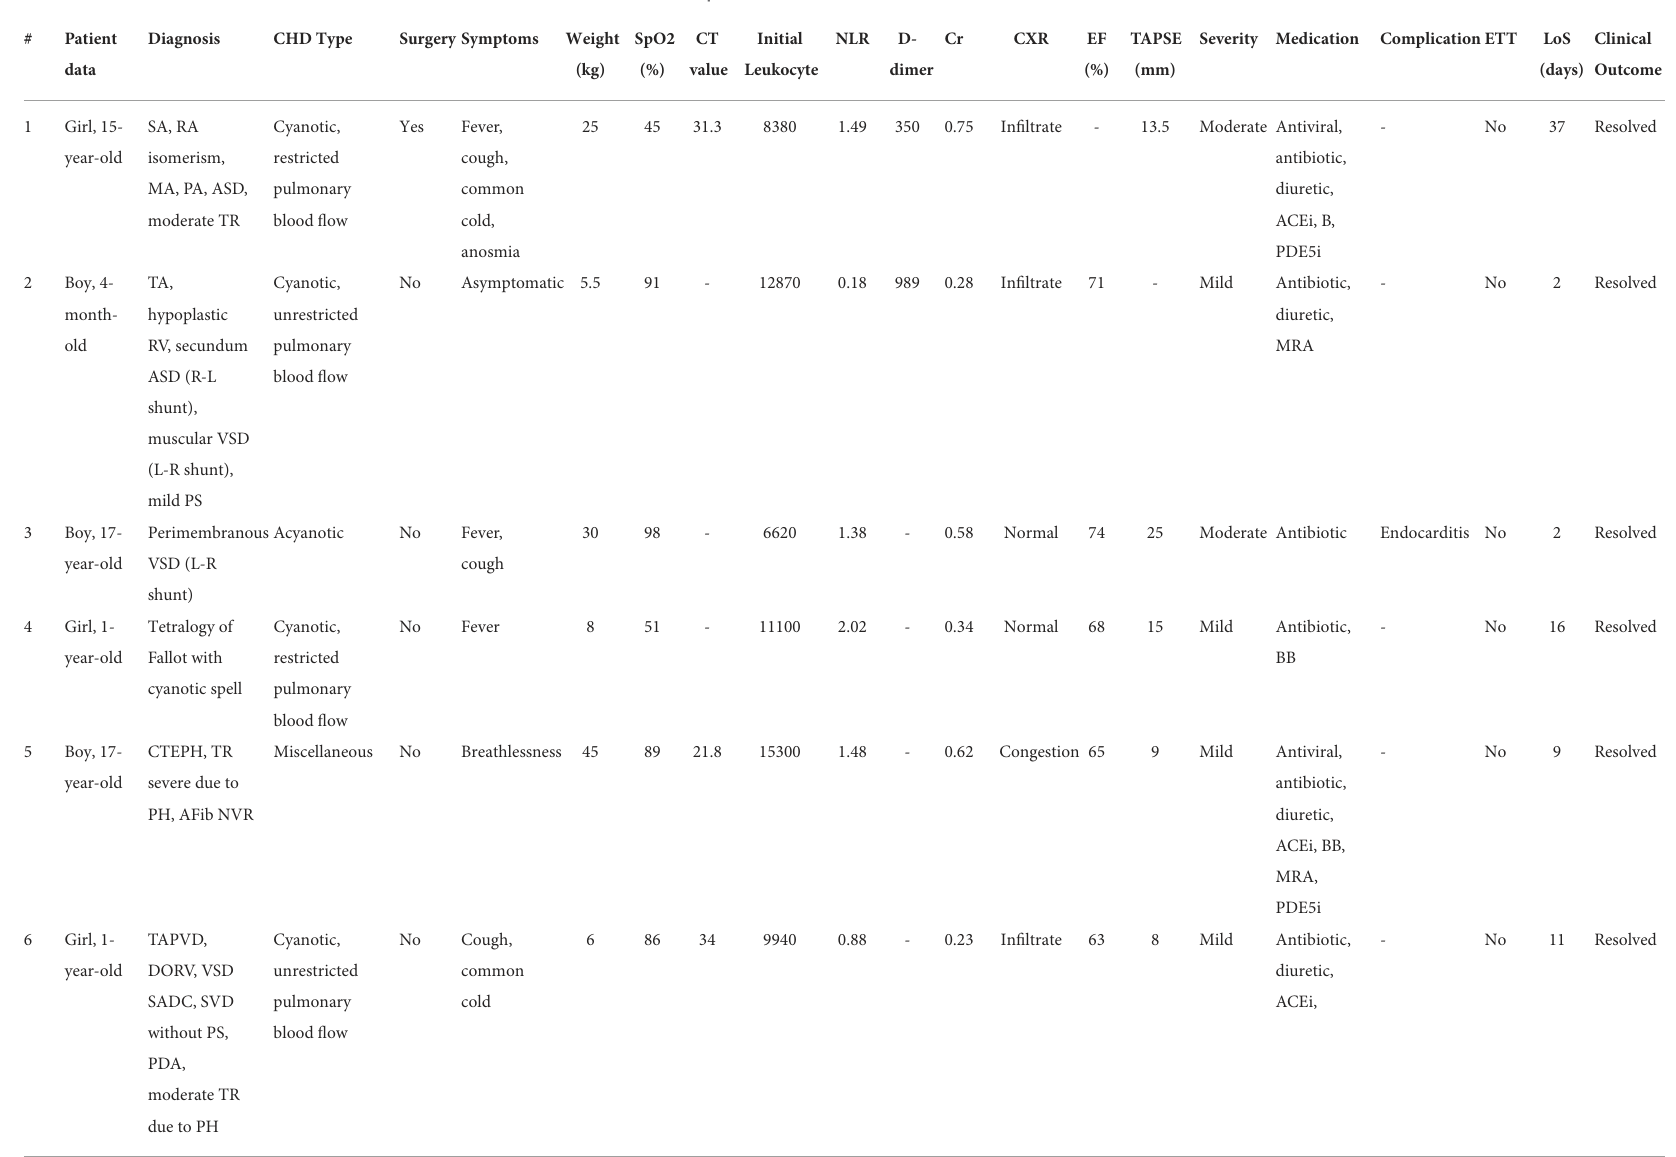
TABLE 3 The individual characteristics, medications, and outcomes of the included